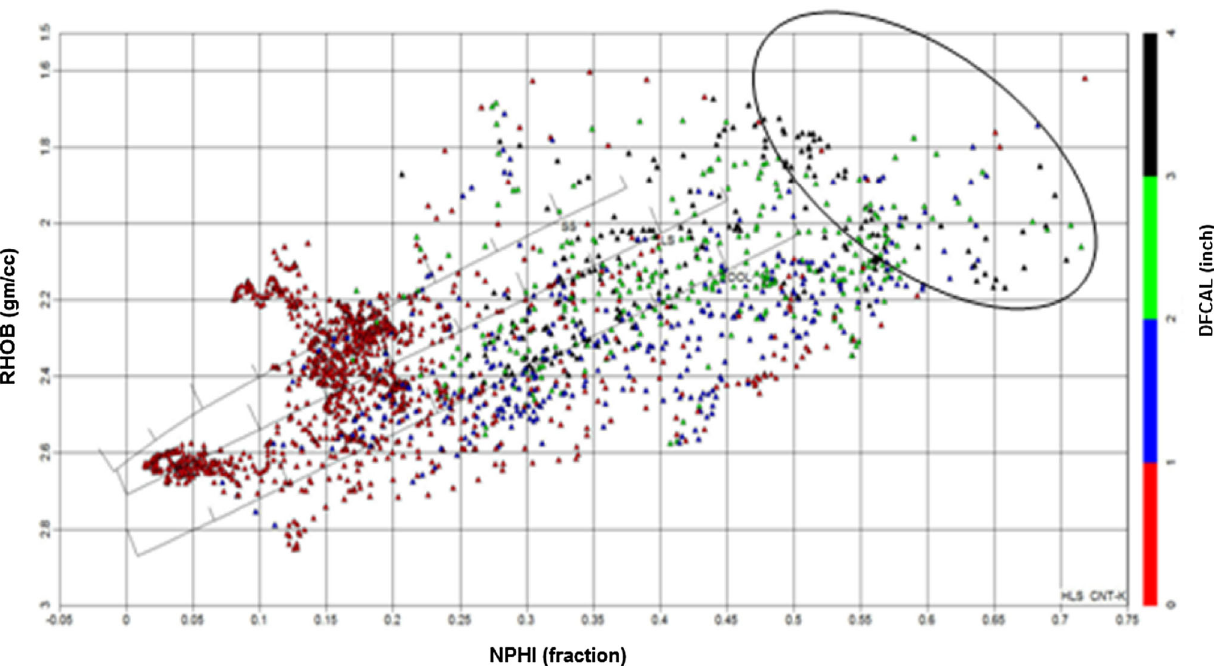
Fig. 2 RHOB versus NPHI cross-plot colored by differential caliper (data falling within the marked circle represent bad data)